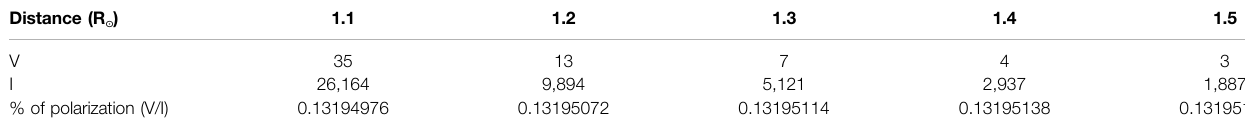
TABLE 5 | Variation of the Stokes-V signal, radially, in the VELC IR channel for a 50 μ m slit width. Distance (R ʘ )